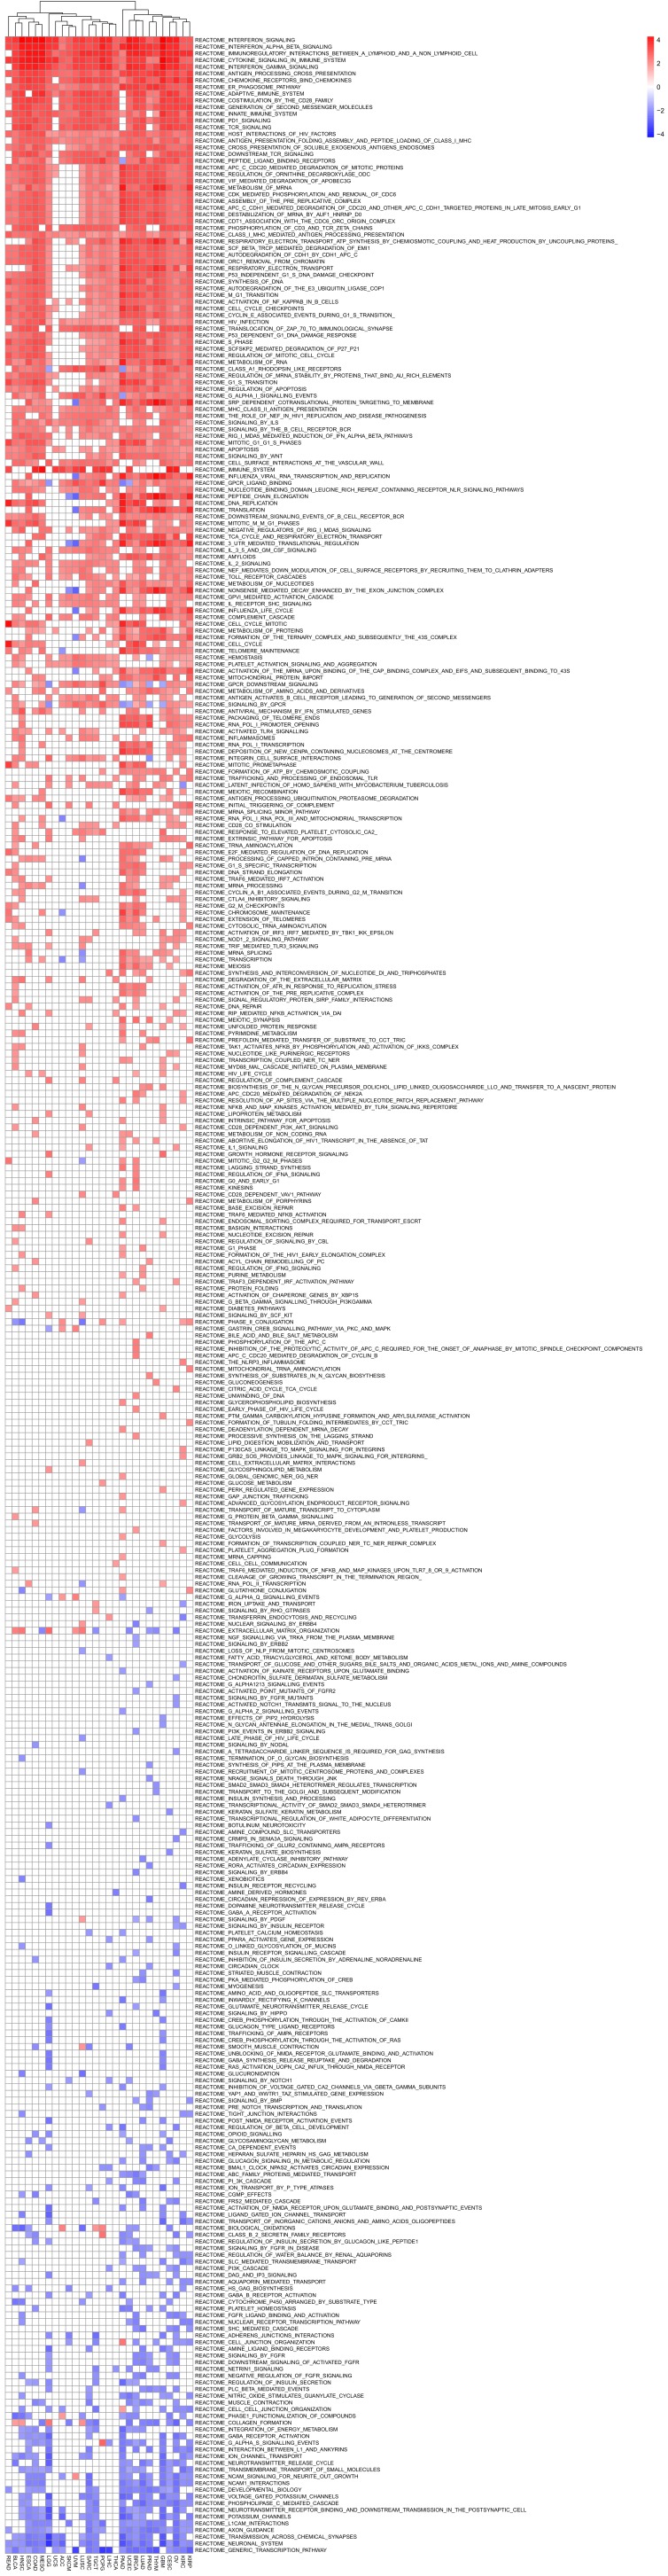
Gene sets that are enriched in 30 types of TCGA cancer patients with high APM score.